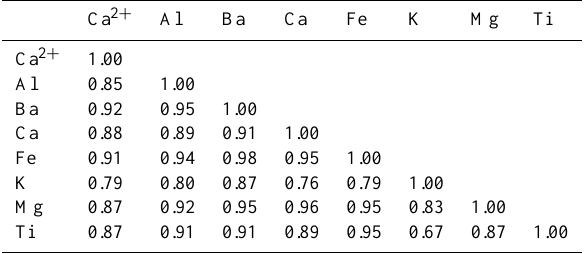
Table 3. Correlation coefficients of dust-derived species in PM 10 during winter ( n = 20, p = 0 . 01).